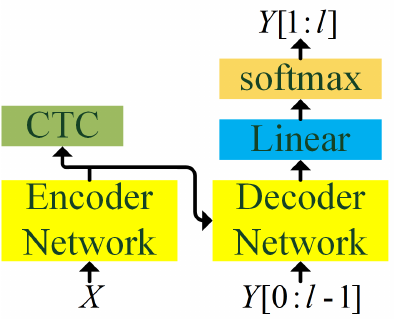
Figure 2. CTC-Transformer baseline